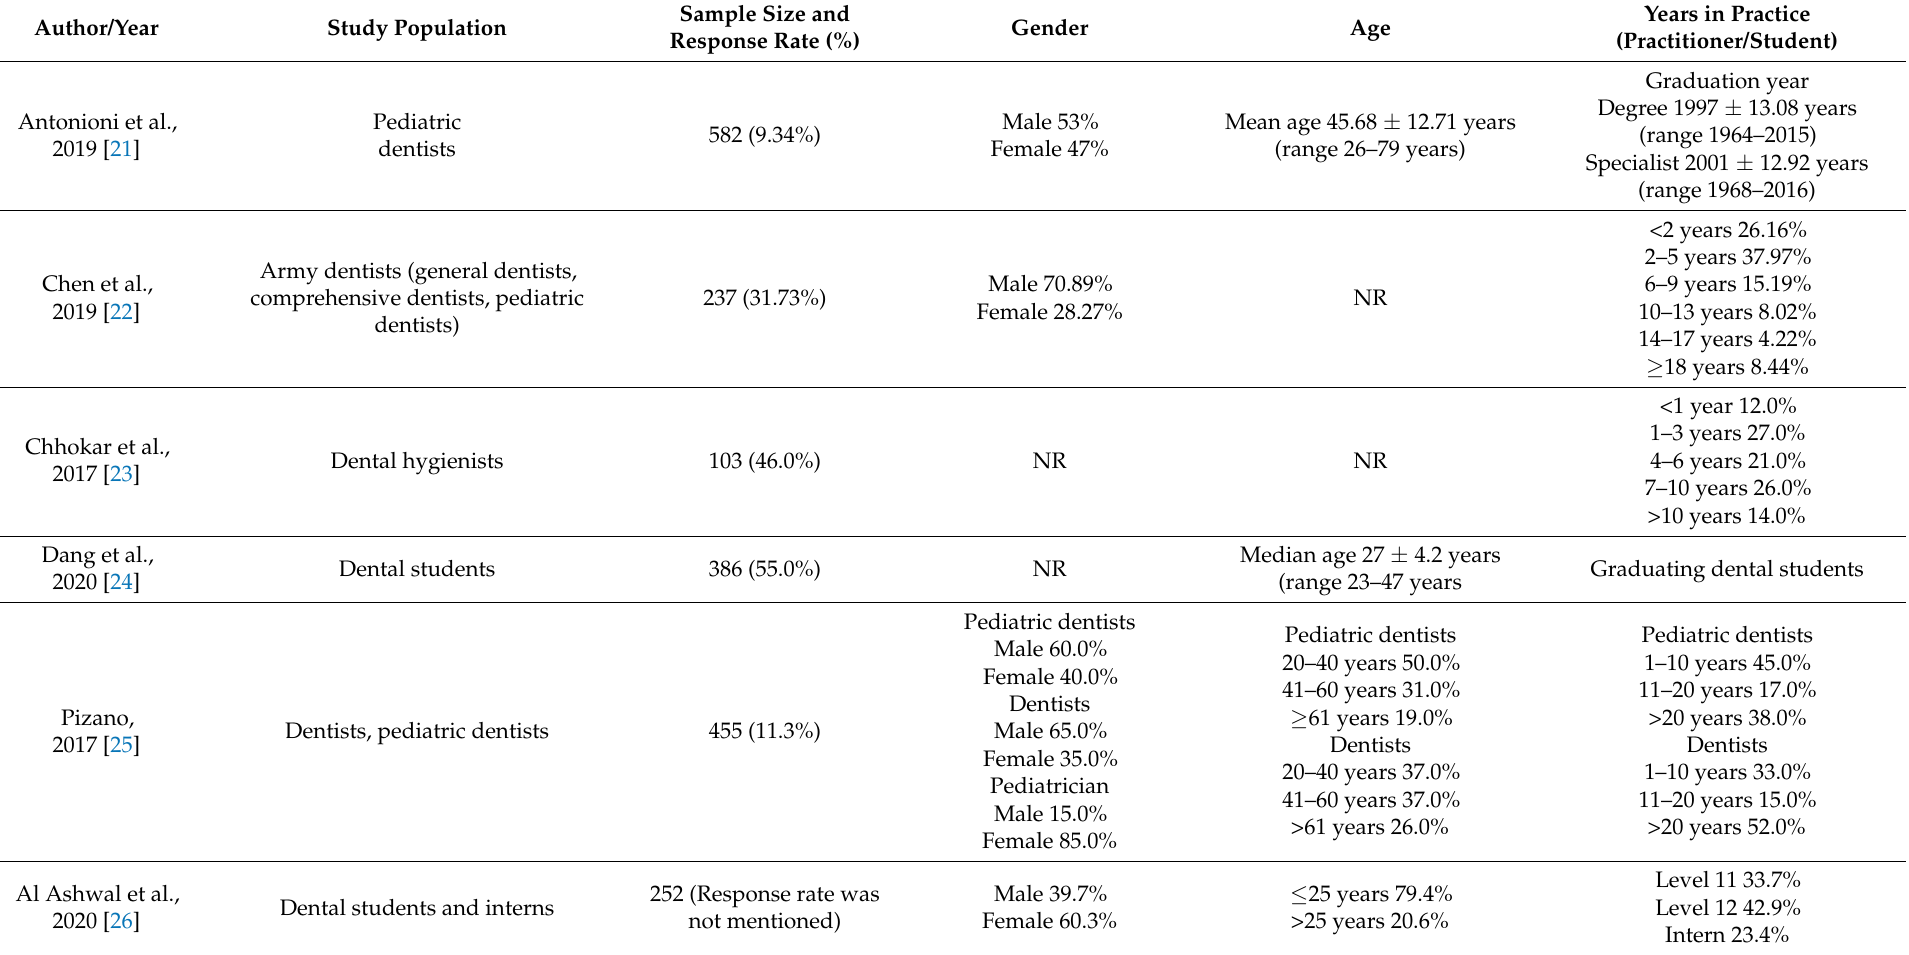
Table 2. Overview of main demographic characteristics of studied